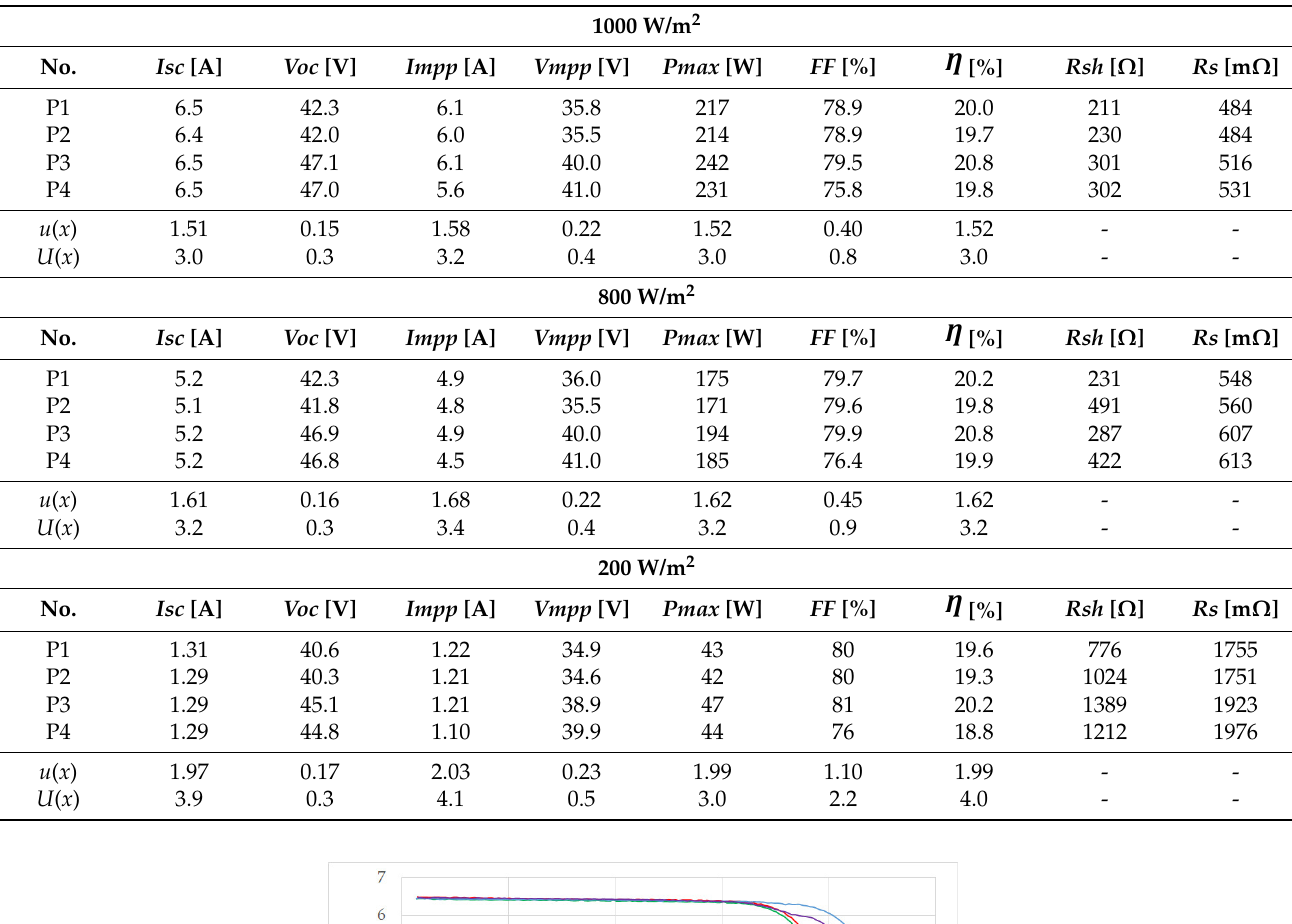
Table 4. Results of electrical parameters measurements for each prototype at different irradiance level with standard and expanded uncertainty. η